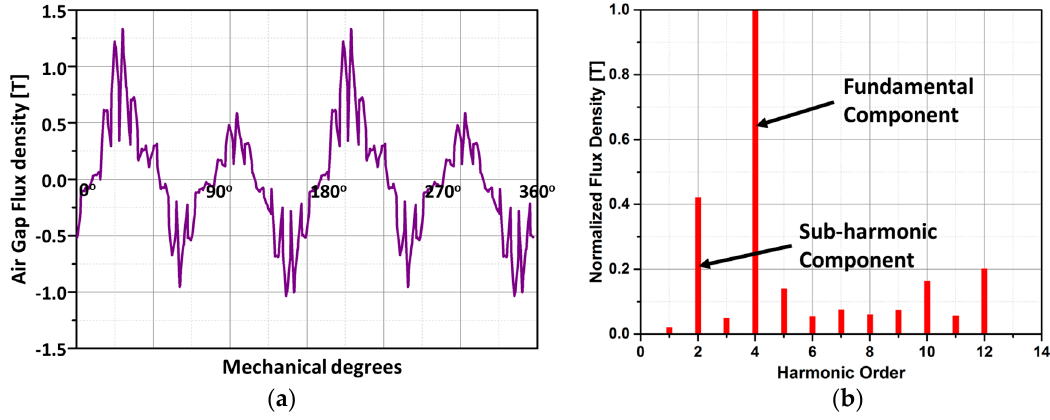
Figure 5. ( a ) Air gap flux density; ( b ) harmonic order of the flux density.